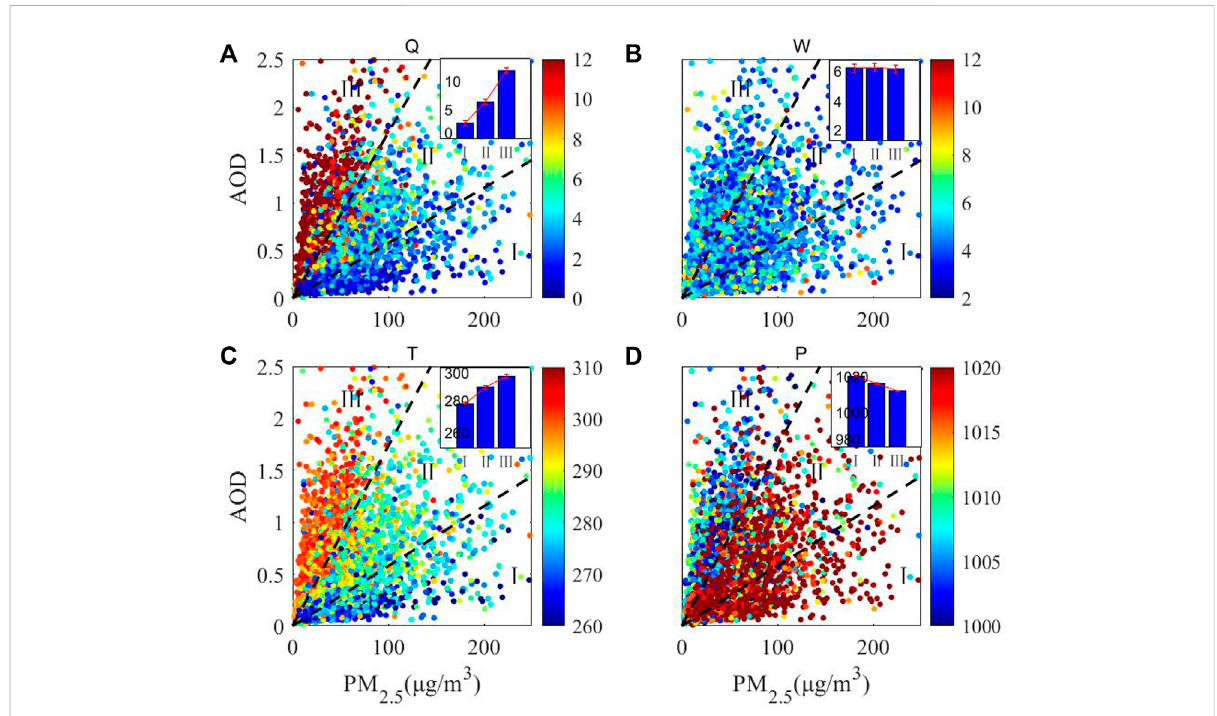
FIGURE 3 DependenceofPM 2.5 -AODrelationshipsonmeteorologicalfactors of (A) speci fi chumidity(gkg − 1 ), (B) windspeed(ms − 1 ), (C) temperature ( ° C), (D) sealevelpressure(hPa)at19SONETsitesinChinafrom2017to2019.EachpointrepresentsaverageAODandPM 2.5 on1 dayatasite,withcolors indicating daily averages of meteorological variables for the same day and site. The scatter plots are divided into three domains, with high ( > 500/3), median (between 300/5 and 500/3), and low ( < 300/5) ratios between PM 2.5 concentrations and AOD from domain I to III. The histograms on the top right showing the average meteorology from ERA5 reanalyses in each domain. Results based on MERRA-2 reanalyses are shown in Supplementary Figure